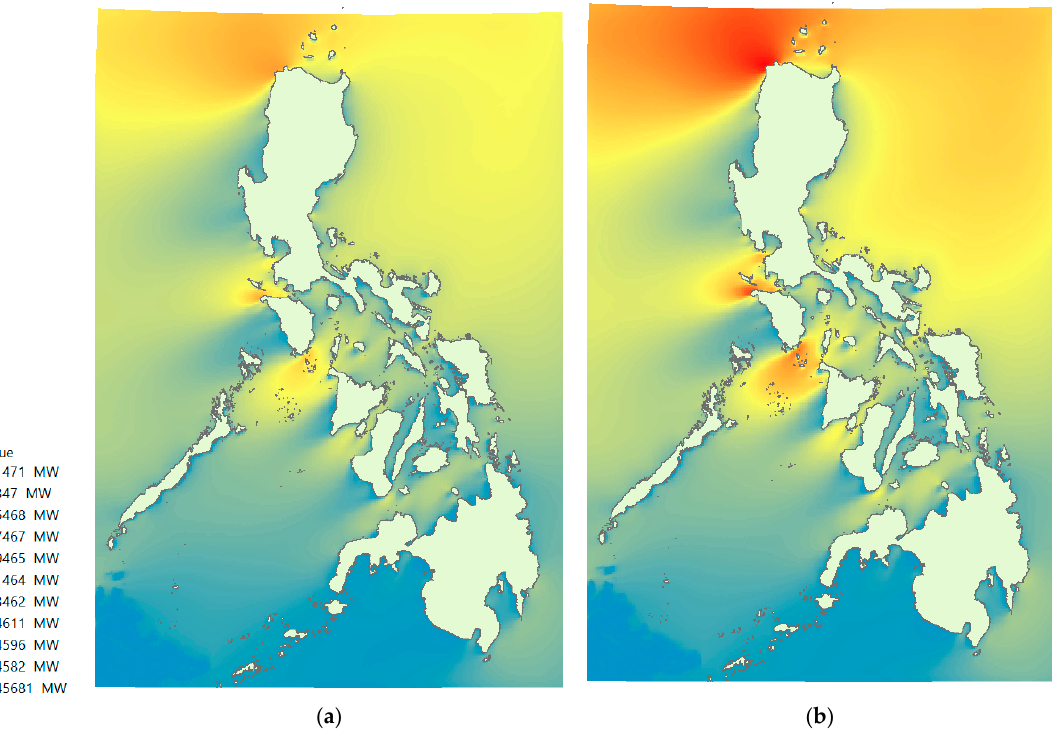
Figure 18. Wind power for ( a ) SWT-3.6-120 and ( b )